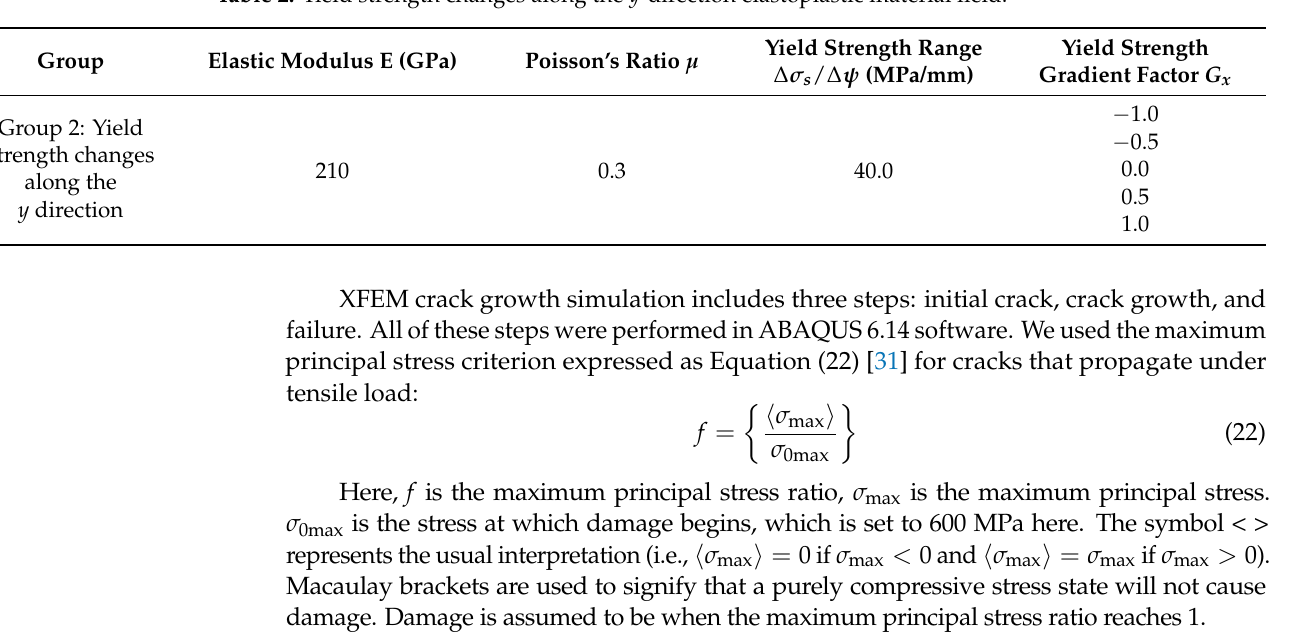
Table 2. Yield strength changes along the y -direction elastoplastic material